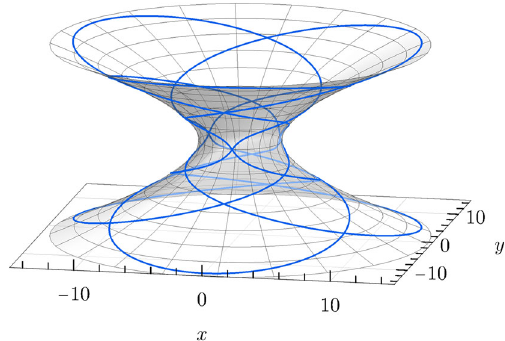
Fig. 34 3D view of the orbit of Fig.